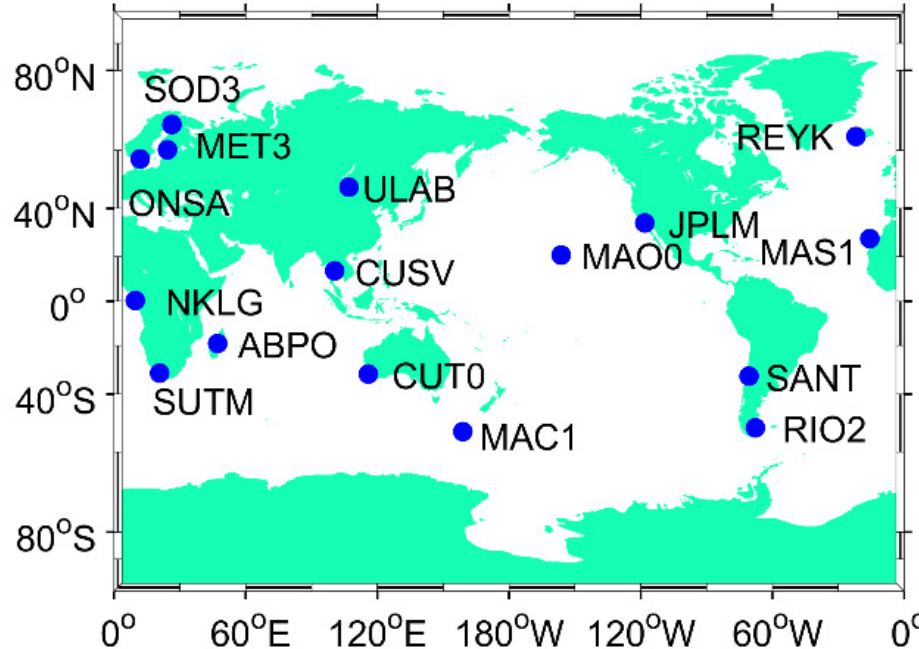
Figure 7. Sixteen globally distributed IGS stations for PPP validation. Table 2. The positioning strategies of PPP. Parameter